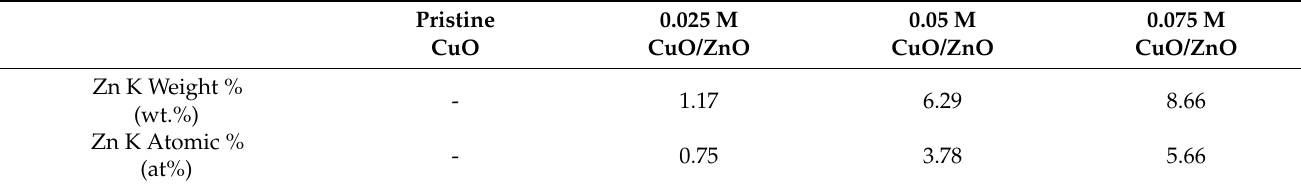
Table 1. EDS analysis of the Zn K peak for different concentrations.